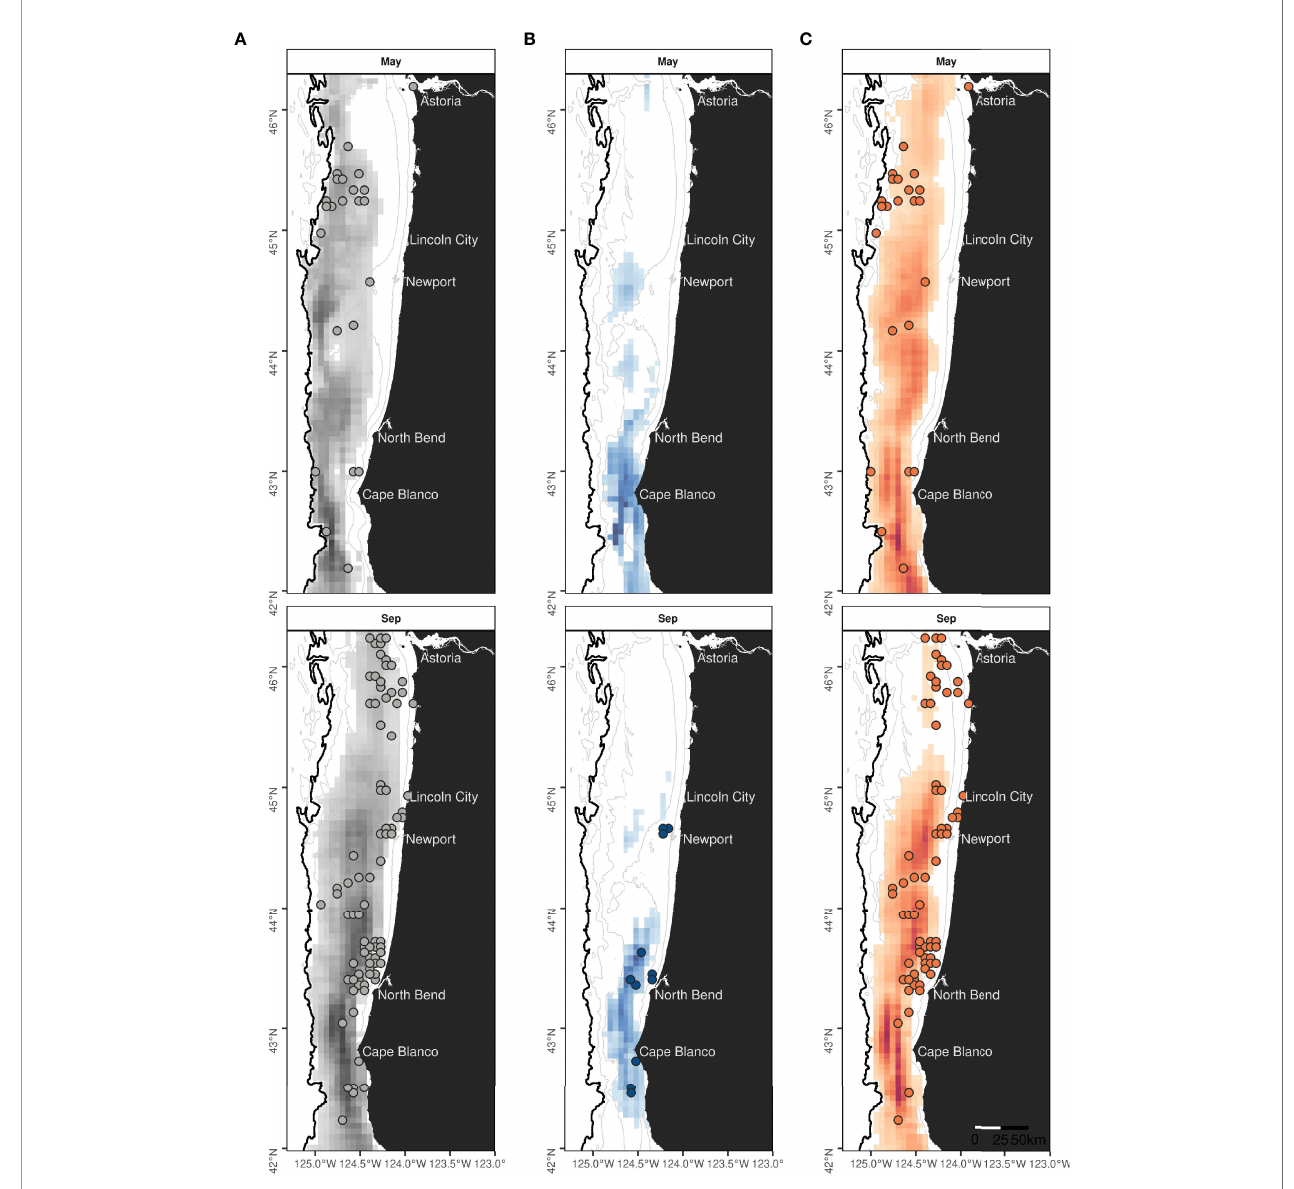
FIGURE 7 | Monthly hotspots predicted over 2016-2021 for rorquals (A) , blue (B) and humpback whales (C) in May and September. The best 75% of the summed and rescaled densities are represented on species-speci fi c colored scales. Land is shown in black. Isobaths (50, 100, 500 and 1,000 m deep) are represented with grey lines. Colored circles mark the position of independent validation sightings of rorquals, blue, or humpback whales recorded in May or September, of 1989 to 2021 (see Supplementary Table S2 for data sources and details). The absence of observations may be due to an absence of survey